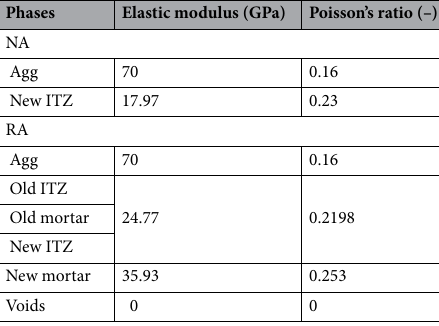
Table 1. Elastic properties of constituent phases at